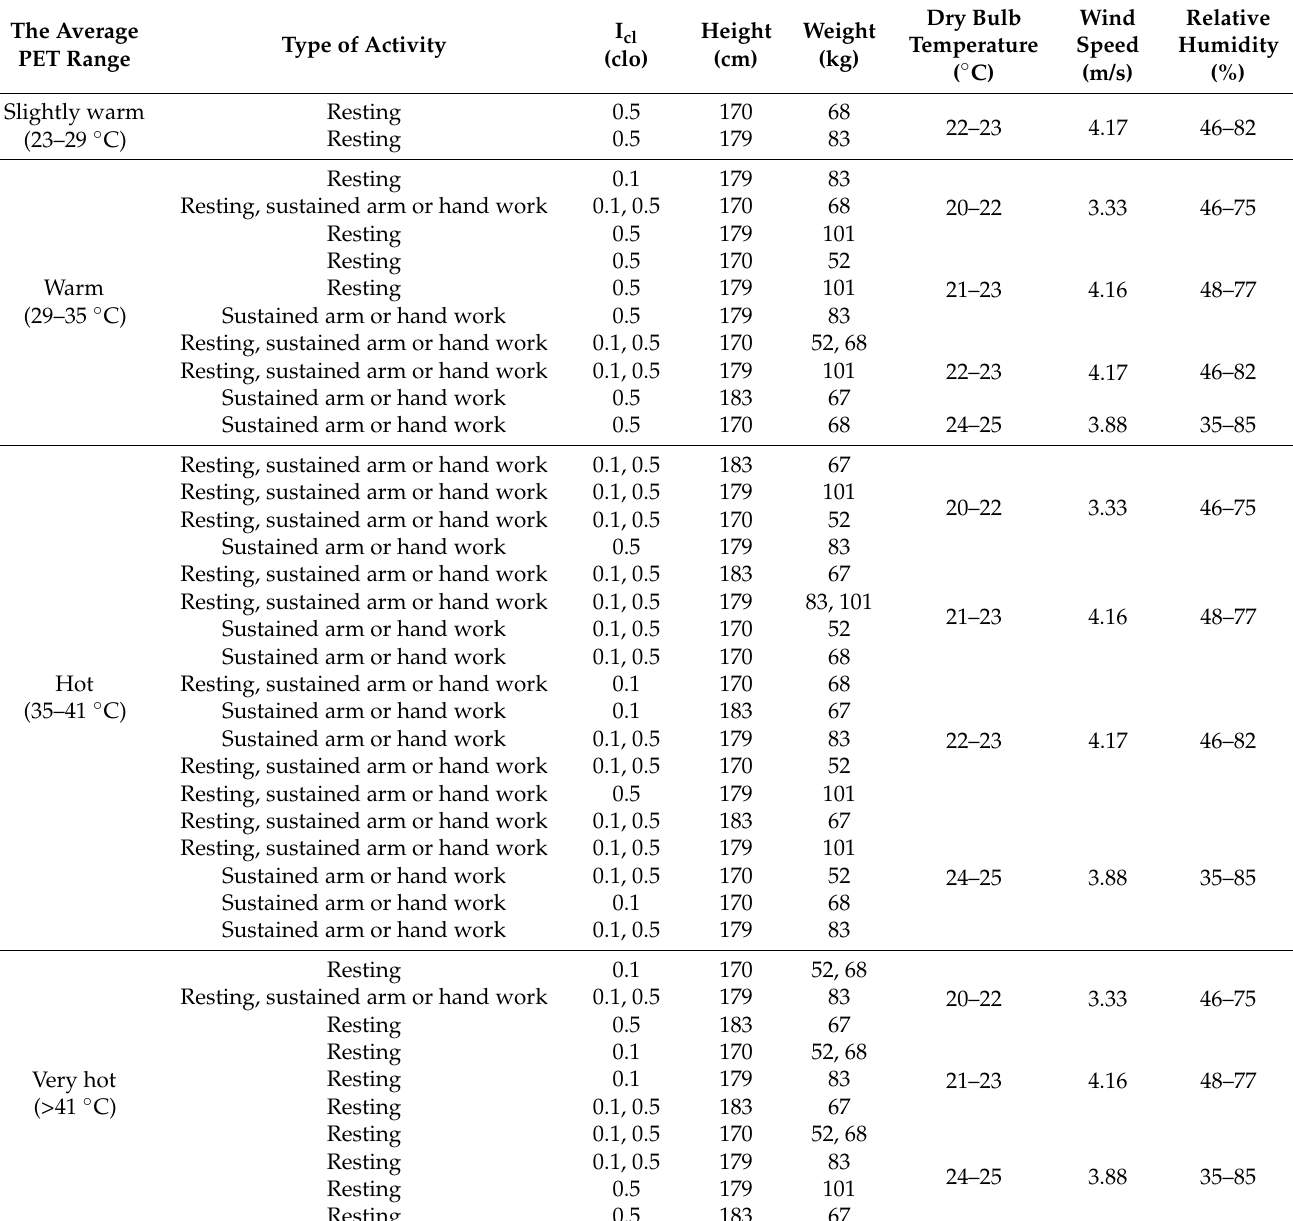
Table 8. Evaluation of PET range in different samples, based on the microclimatic